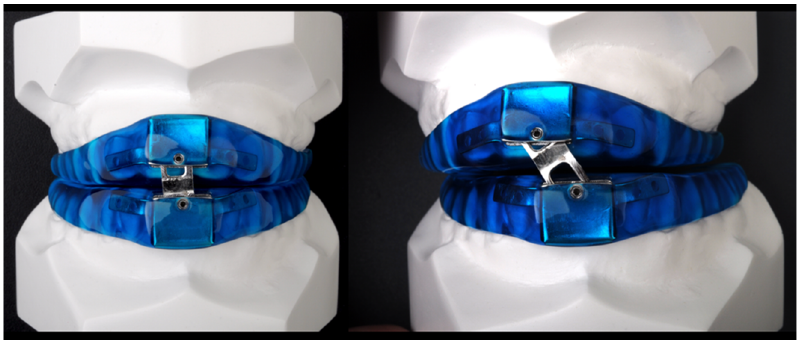
Figure 1. DAM ® : a customized, titratable two-piece mandibular advancement